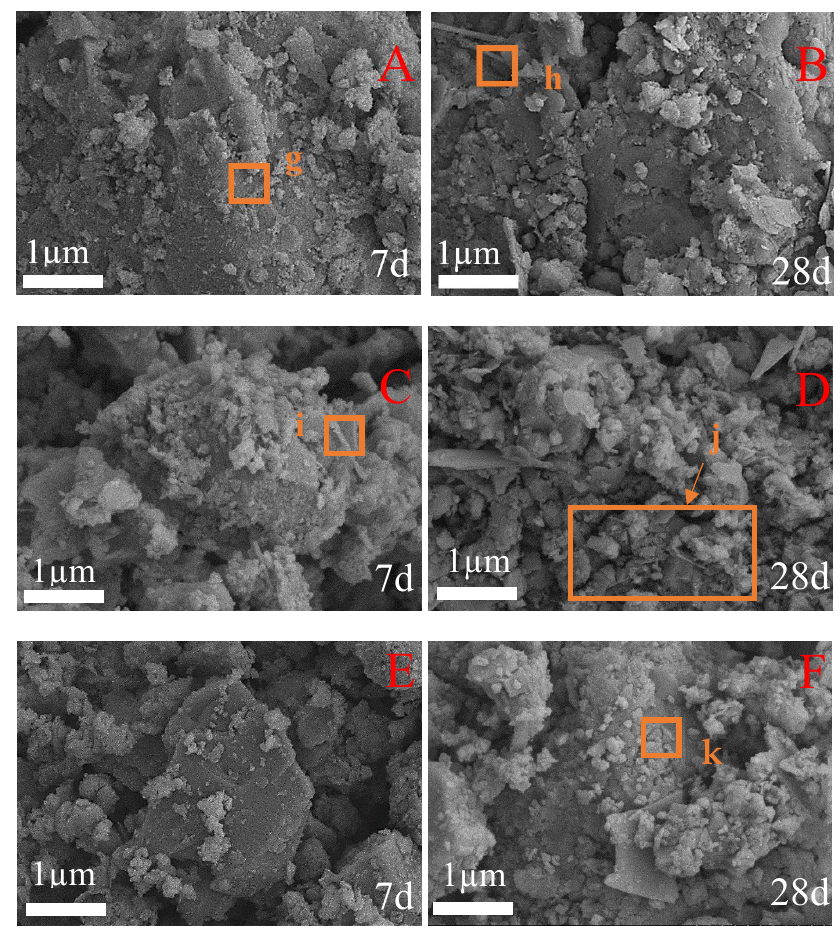
Figure 6. SEM chart of subgrade materials for CSS base pavement: ( A ) CFC-1 cured 7 d, ( B ) CFC-2 cured 28 d, ( C ) CFC-2 cured 7 d, ( D ) CFC-2 cured 28 d, ( E ) CFC-7 cured 7 d, ( F ) CFC-7 cured 28 d.